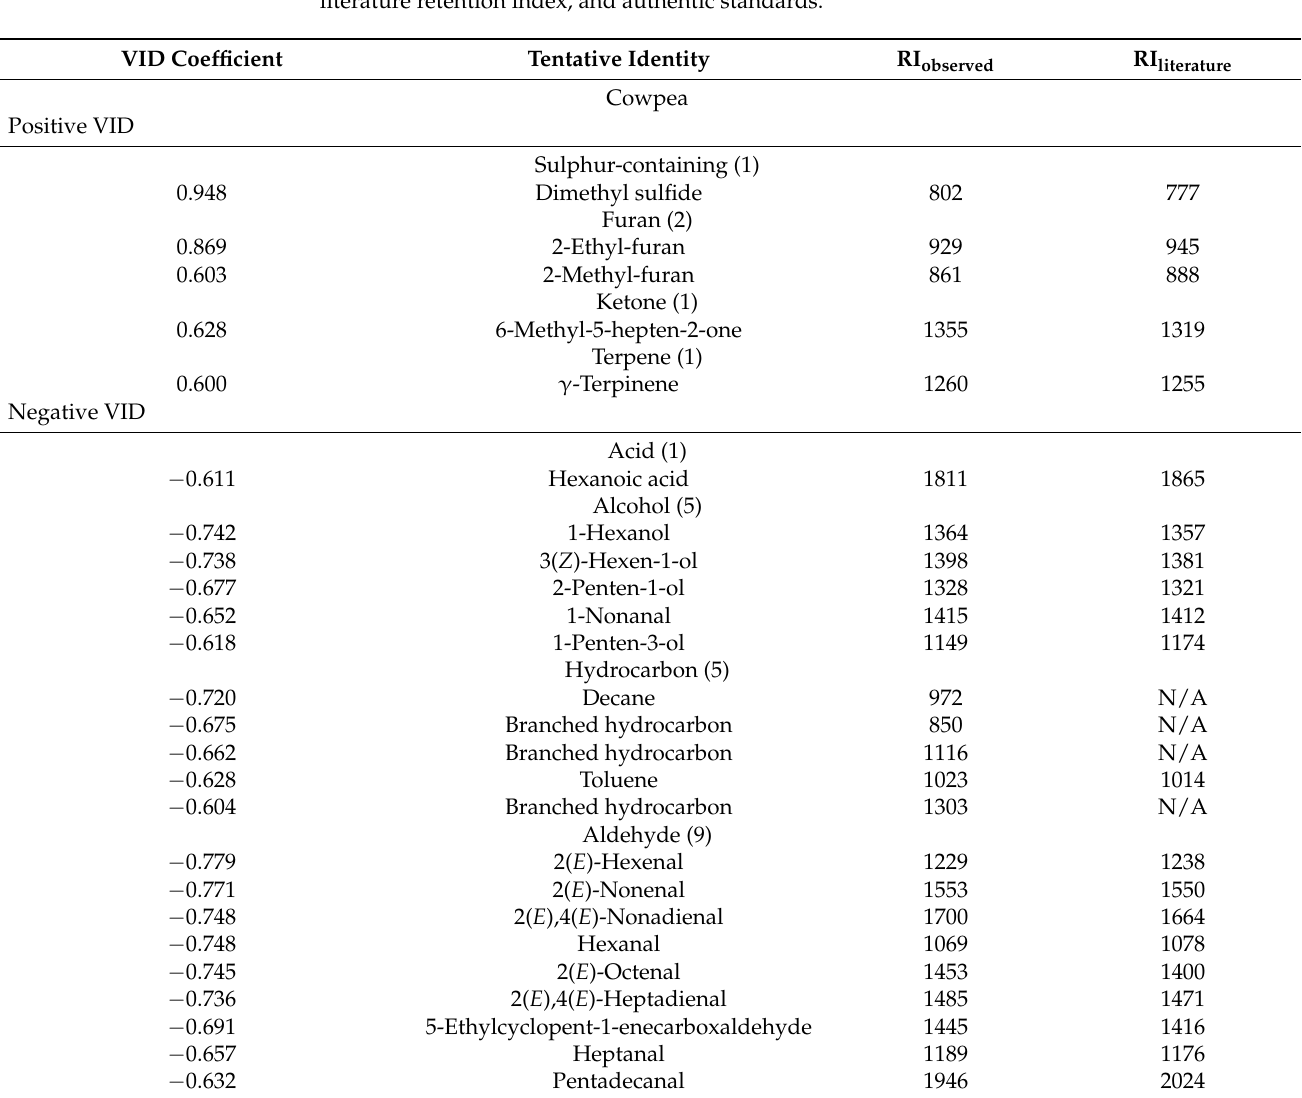
Table 3. Discriminant volatile compounds changing during closed system hydrothermal processing of cowpeas, chickpeas and kidney beans as tentatively identified by NIST spectra, matching with the literature retention index, and authentic